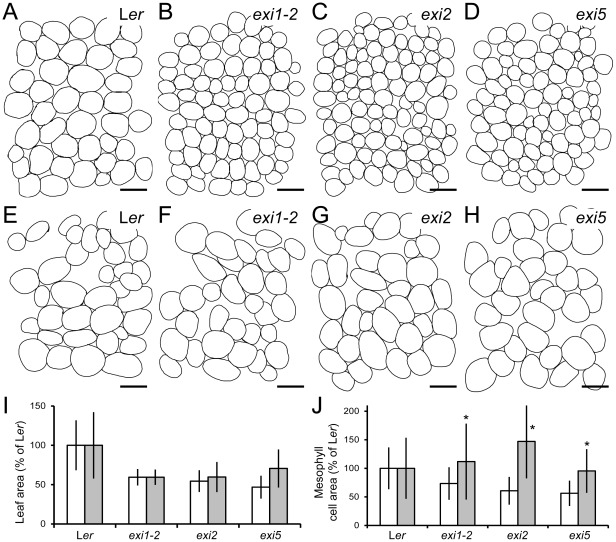
The cell expansion defects of the exi mutants are rescued by liquid culture.(A–H) Leaf mesophyll of the exi mutants. Diagrams were drawn from differential interference contrast micrographs of cleared first-node leaves collected from (A, E) Ler, (B, F) exi1-2, (C, G) exi2 and (D, H) exi5 plants. (I, J) First-node leaf (I) lamina area and (J) mesophyll cell area in the exi mutants. Data were normalized with respect to the Ler values and are expressed as percentages (mean and standard deviation). Asterisks indicate significant differences from the control seedlings grown on half-strength MS agar medium (P value<0.01). All the data were obtained 21 DAS from seedlings grown on half-strength MS agar plates (A–D, white bars) or in half-strength MS liquid cultures (E–H, grey bars). Scale bars indicate 50 µm.